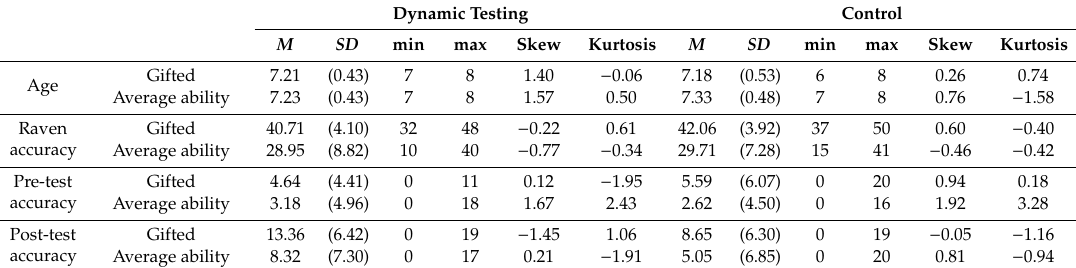
Table A3. Descriptive statistics for age, Raven accuracy, pre-test accuracy, and post-test accuracy divided by ability group and